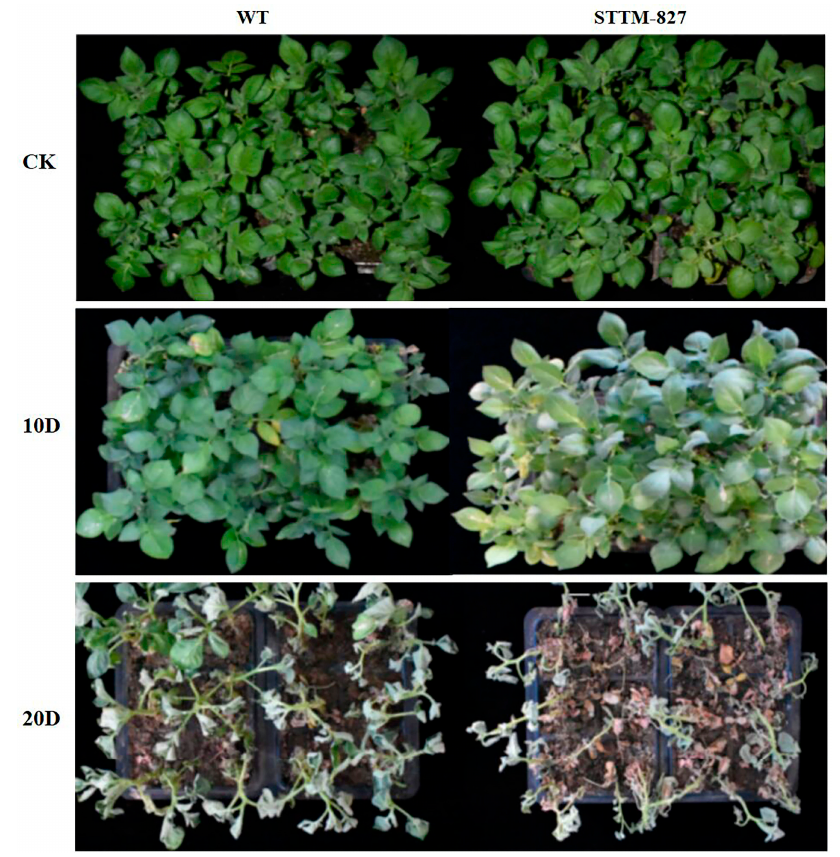
Figure 4. Drought resistance of transgenic potato plants stably overexpressing STTM-miR827-5p fragment. WT: wide potato plants; STTM-827: transgenic potato plants stably overexpressing STTM- miR827-5p fragment; CK: WT and transgenic plants without drought treatment; 10D: the drought symptoms of WT and transgenic plants after the 10th day of drought treatment; 20D: the drought symptoms of WT and the transgenic plants after the 20th day of drought treatment.